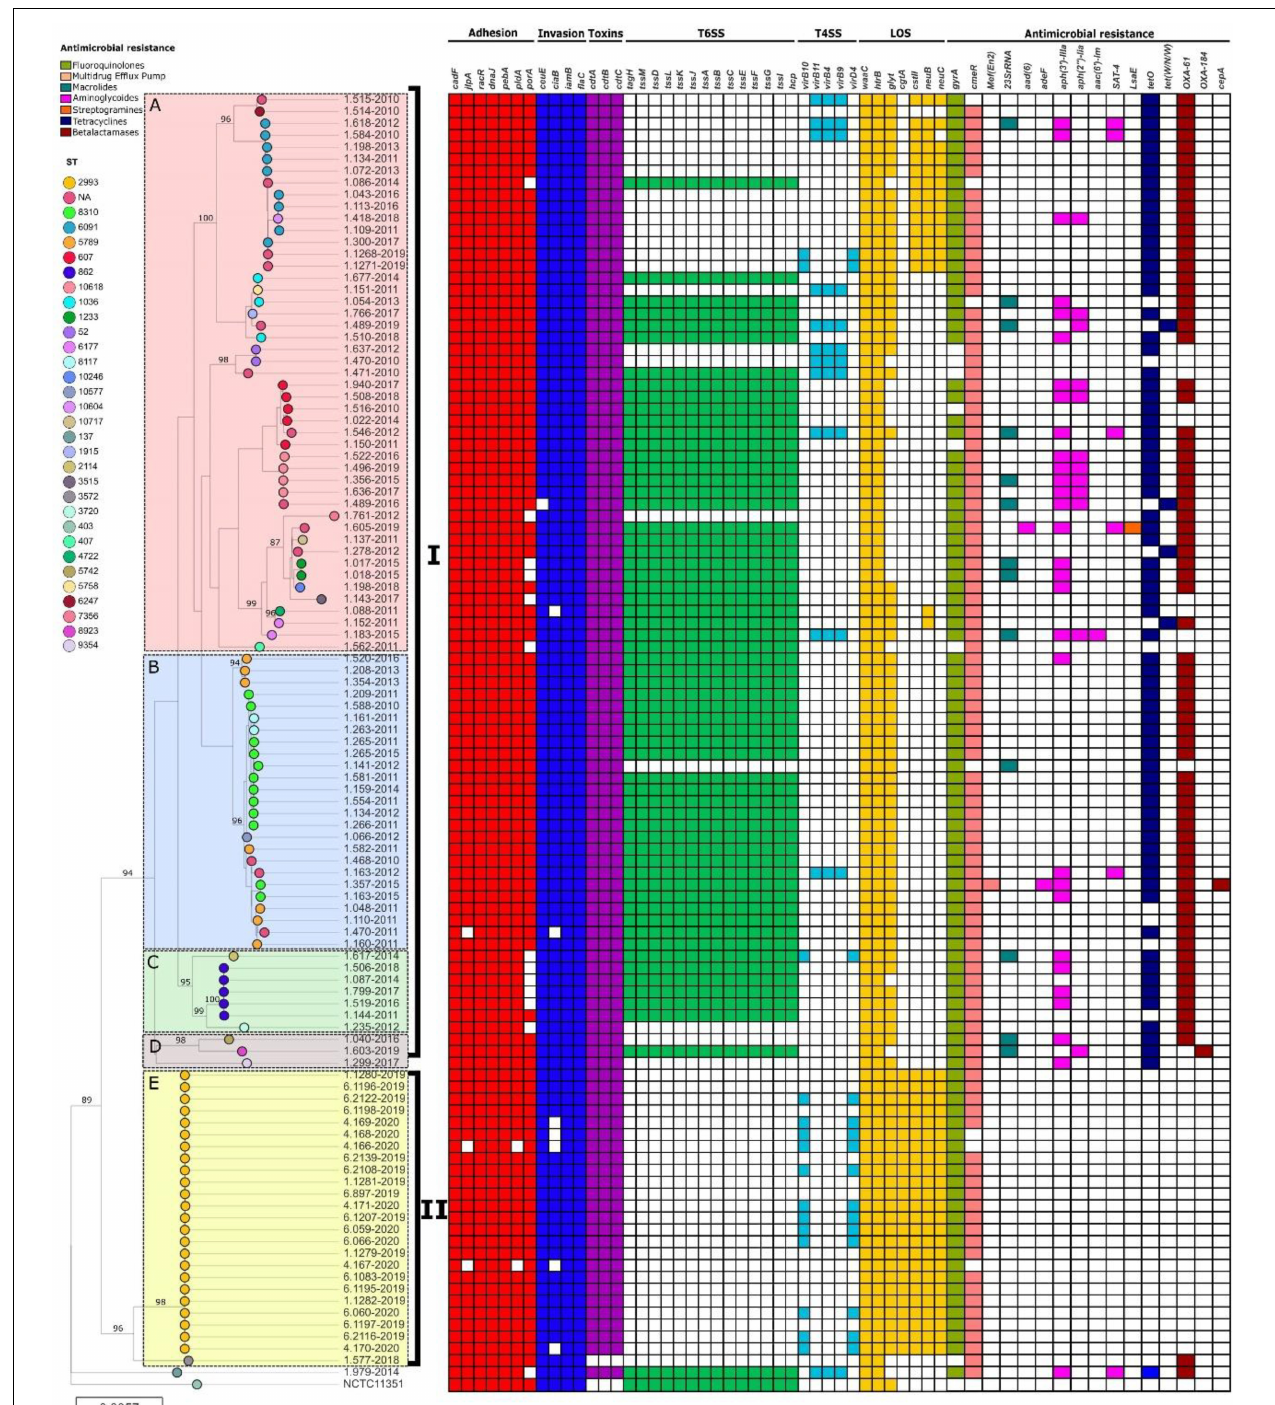
FIGURE 2 | Phylogeny of C. jejuni ( n =108) constructed by maximum likelihood using strain NCTC11351 as reference. The strains are represented by circles connected by branches proportional to the phylogenetic distance. The code of each strain is indicated as a label parallel to the corresponding circles. The genotypes (ST) among the studied population are denoted by different colors. The clades are denoted by the numbers I and II. The HierBAPS populations are highlighted by colored boxes and named A–E. The presence of virulence genes is denoted by blocks in color based on six categories: Adhesion (Red), Invasion (Blue), Toxins (Purple), T6SS (Green), T4SS (Light Blue), and LOS (Yellow). The presence of resistance genes is denoted by blocks in color according to the spectrum of action: Fluoroquinolones (green), Multidrug Efflux pump (Red), Macrolides (Blue), Aminoglycosides (Pink), Streptogramins (Orange), Tetracycline (Blue) and Beta-Lactamases (Brown). The names of detected genes are indicated above the blocks. The absence of a gene is indicated by a white block.